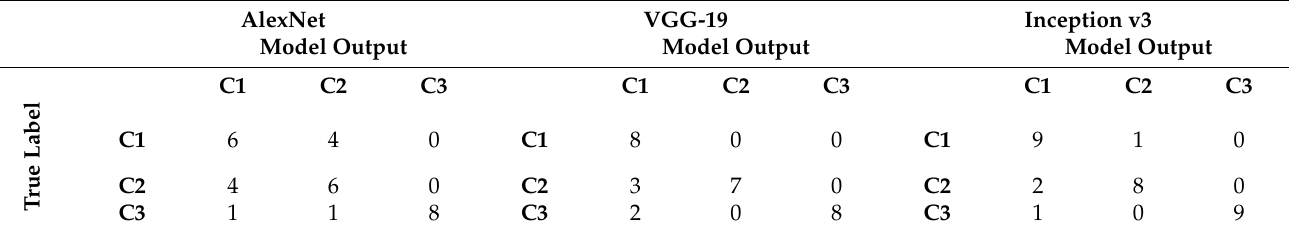
infection, and C3 represents the esca